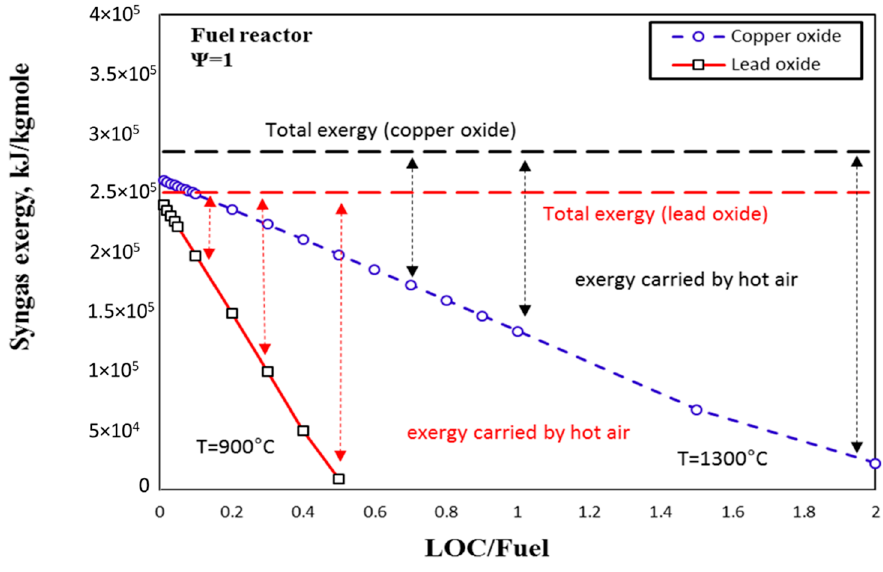
Figure 9. Dependence of exergy carried by syngas and hot gas on the LOC/fuel ratio.